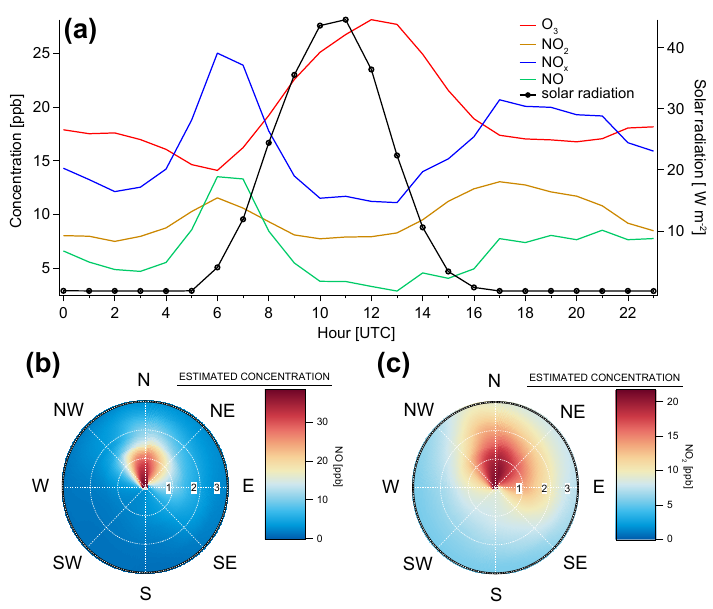
Figure 2. ( a ) Diurnal trend for ozone (red line), nitrogen dioxide (orange line), nitric oxide (green line), nitrogen oxides (blue line) and solar radiation (black line), computed for the cold season between 1 December 2017 and 4 March 2018. Source estimations for: ( b ) NO (ppb, shaded according to the scale); and ( c ) NO 2 (ppb, shaded according to the scale). For the source estimation plots, the inner white circles represent the wind speed in m s − 1